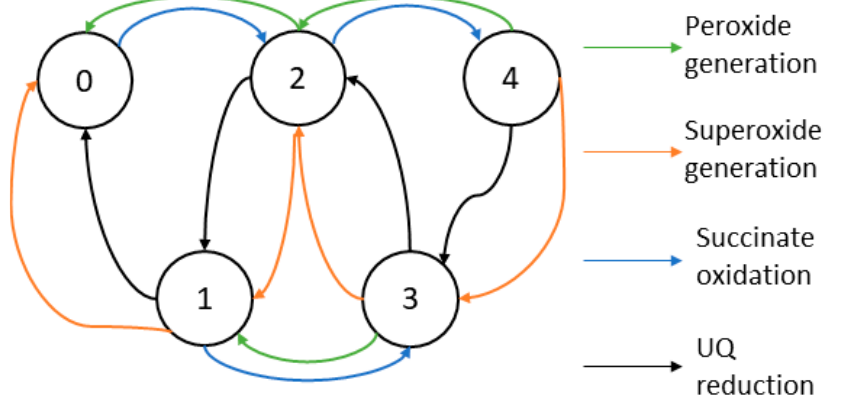
Figure 6. Schematic of the complex II model by Manhas et al. [84]. The 5 states represent the number of electrons in complex II. The model includes peroxide generation reactions (green arrows) taking two electrons from complex II to oxygen, superoxide generation reactions (orange arrows) taking one electron from complex II to oxygen, succinate oxidation reactions (blue arrows) taking two electrons from NADH to complex II, and finally ubiquinone reduction reactions (black arrows) taking one electron from complex II to ubiquinone. The figure was reprinted/adapted from Ref. [84].